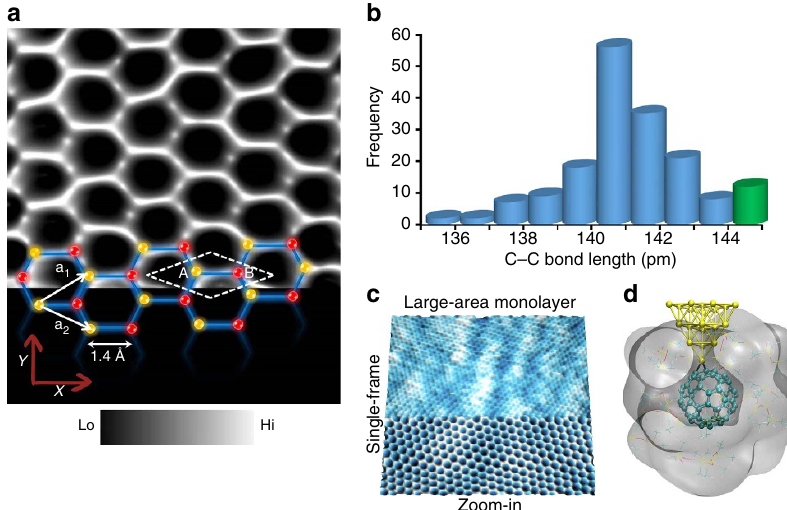
Figure 4 | Liquid-stabilized molecular probe for bond length quantification. ( a ) High magnification constant-current STM image within a graphene monolayer region acquired using a single C 60 molecular probe showing the local arrangement of the atomic lattice of graphene ( I t ¼ 200pA, V b ¼ 0.5V, scan size: 1.7nm (cid:4) 1.2nm). The yellow and red spheres point to the two equivalent carbon atoms present within a primitive unit, indicated by the white dashed rhombus and lattice vectors a 1 and a 2 , within a monoatomic sp 2 bonded network of graphene. ( b ) Statistical distribution of C–C bond lengths measured using a C 60 -molecular probe on a monolayer of graphene spanning an area of B 200nm 2 . The statistical distribution shown in b is based on systematic analysis over a large-area monolayer (90nmnm (cid:4) 125nm) followed by zoom-in (11.3nm (cid:4) 10.3nm, on specific locations to extract the C–C bond distance values ( c ). The scanning parameter remain constant, ( I t ) ¼ 155pA, ( V b ) ¼ 0.6V. The upper C–C bond length values displayed in the histogram coded in green were measured using the molecular probe on atomic hexagons near the vicinity of point defects on monolayer graphene. Scan speed parameter for a and c was 2Hz and 12Hz at 512 (cid:4) 512 lines per scan, respectively. ( d ) Snapshot of the final simulated tip structure obtained after 50ns of equilibrated room temperature molecular dynamics of the C 60 -functionalized gold tip in silicone oil. Silicone oil molecules within 5Å of C 60 are shown as lines with oxygen atoms coloured red, hydrogen white, carbon cyan and silicon yellow, and space-filling surface is overlaid (radius scale 1.2, density isovalue 1.0 and grid spacing 0.5—generated using visual molecular dynamics (VMD) software). More distant silicone oil molecules are omitted for